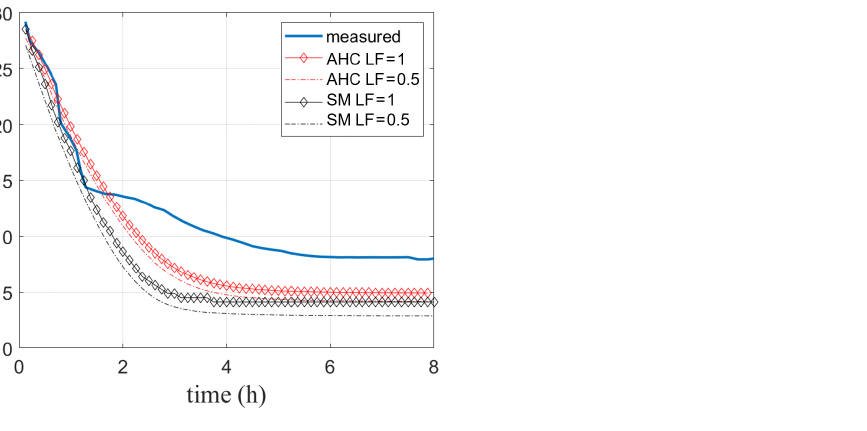
Figure 10. Simulated and visually measured phase front position during melting of RT64HC con- ducted in [4].